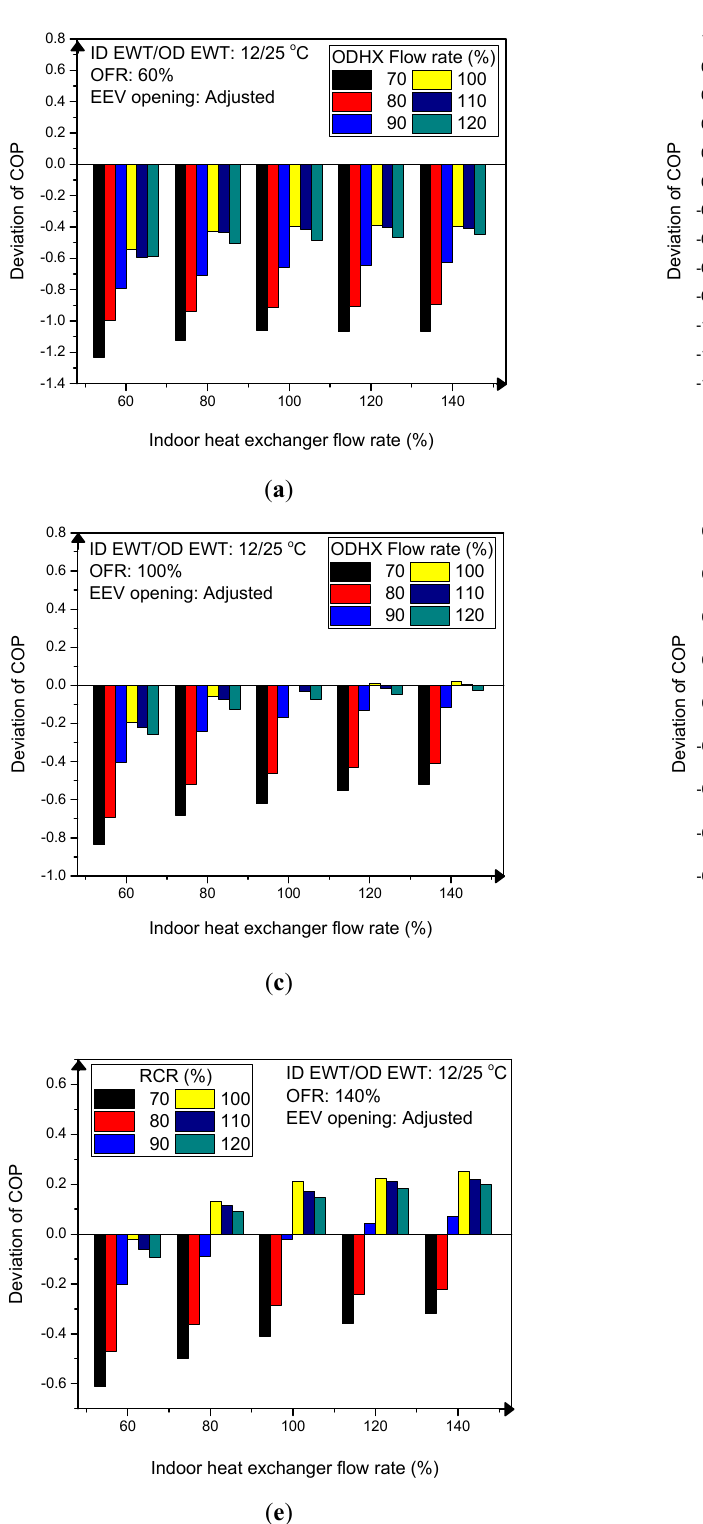
Figure 9. Change in COP according to refrigerant charge ratio and flow rate of secondary fluid in indoor and outdoor heat exchanger of ( a ) 60%, ( b ) 80%, ( c ) 100%, ( d )120% and ( e ) 140%.